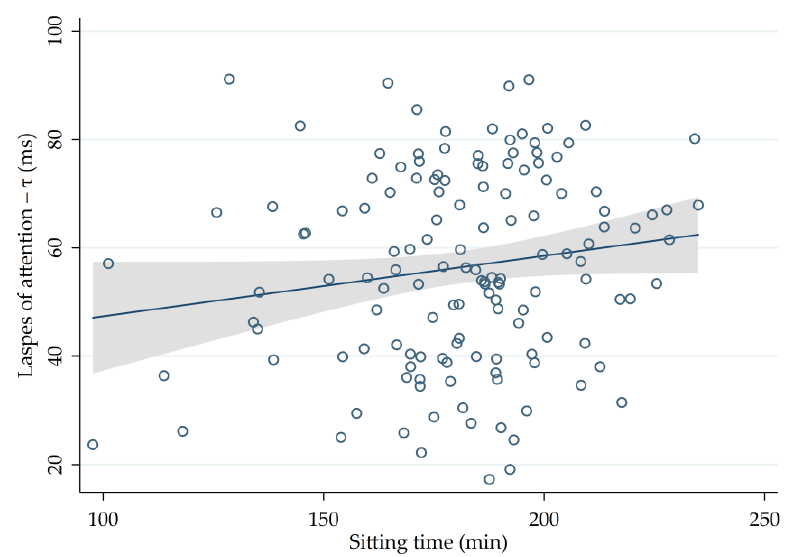
Figure B1. Scatterplot showing the correlation between sitting time and lapses of attention ( r = 0.16, p = 0.06).